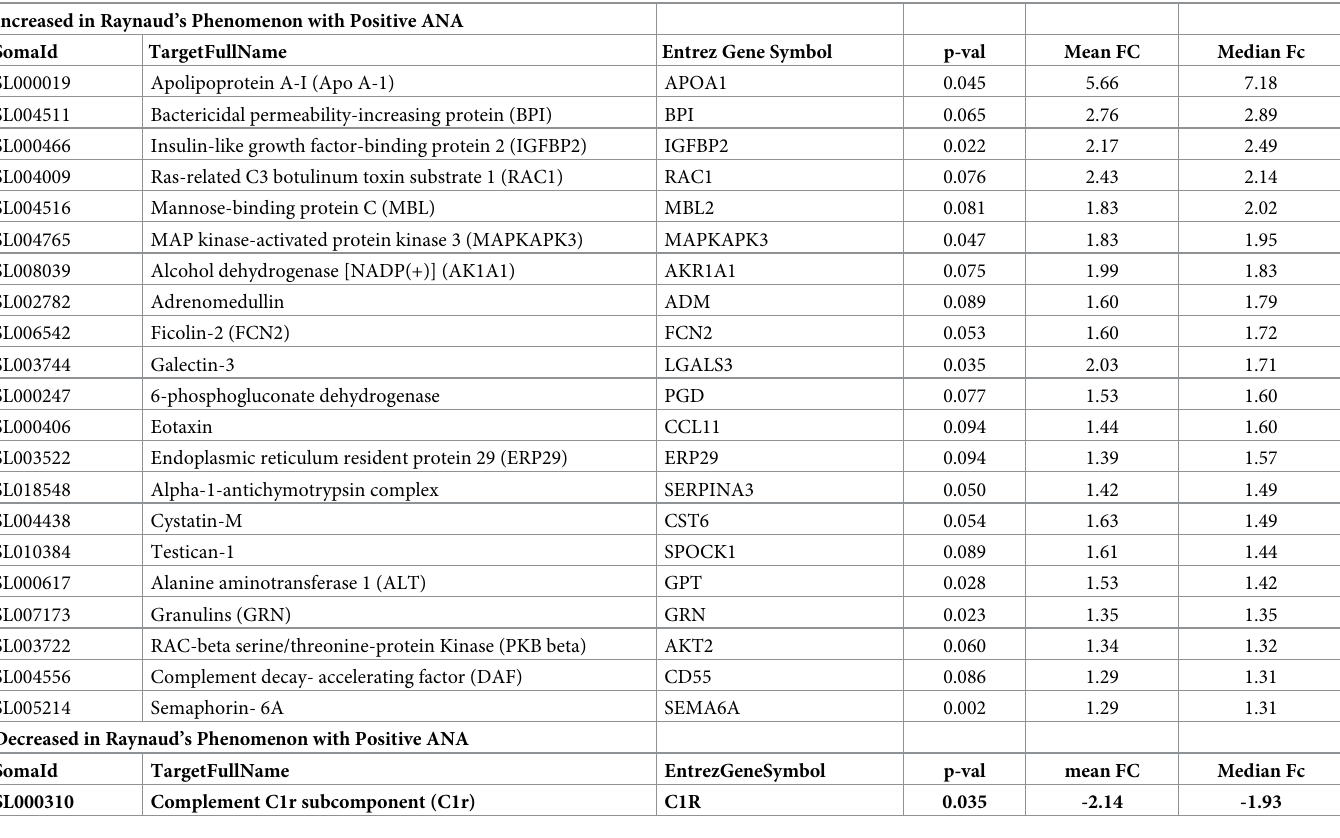
Table 1. Top elevated ( > 1.30-fold and p value < 0.1) and decreased ( < 1.30-fold and p value < 0.1) proteins from serum exosomes of patients with Raynaud’s Phe- nomenon with positive ANA compared with serum exosomes from patients with Raynaud’s Phenomenon with negative ANA identified by aptamer